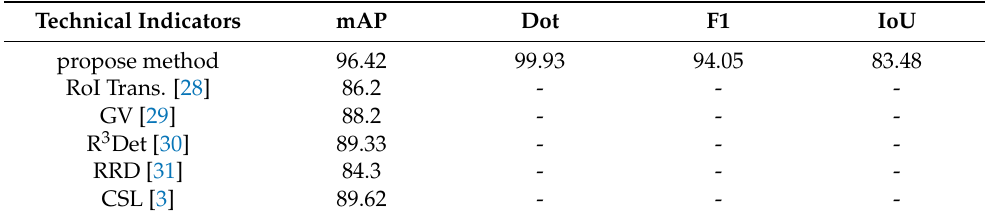
Table 4. The accuracy indexes of the HRSC data set test